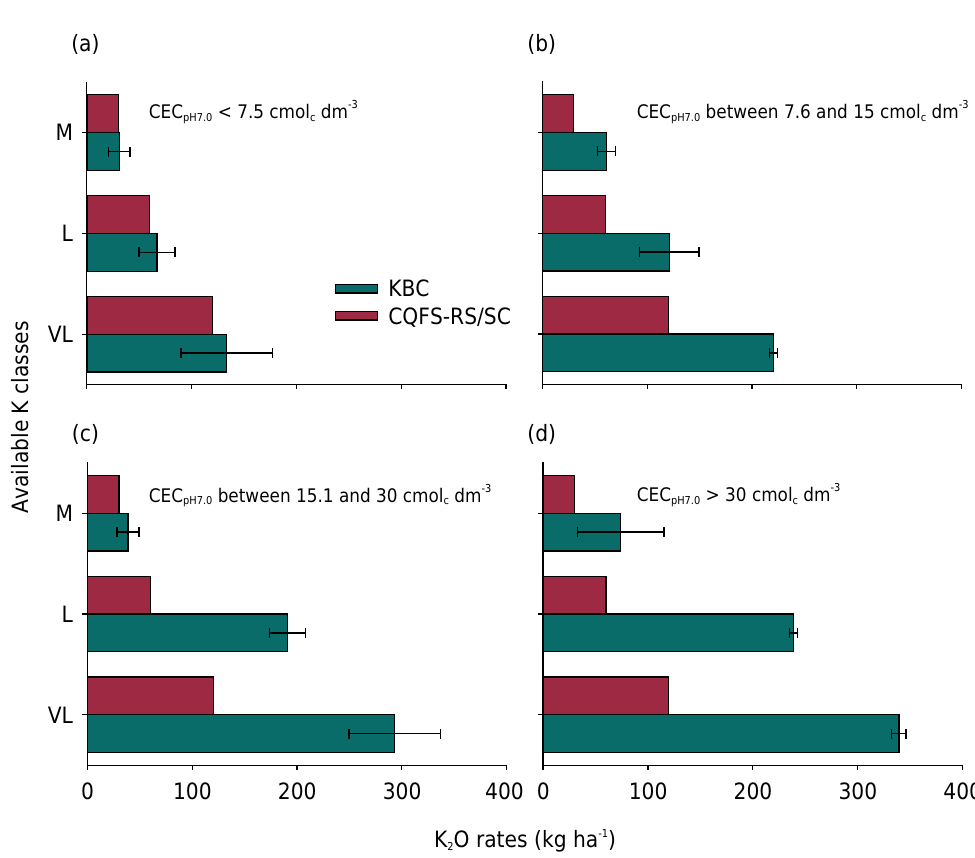
Figure 5. Comparison between the potassium (K) corrective fertilization recommendations between the Local Soil Fertility Committee and using the K buffering capacity (KBC), considering soils with different CEC pH7.0 . VL: Very Low; L: Low; M: Medium. Soils classified as “very low” had soil test K <20 mg dm -3 (a), <30 mg dm -3 (b), <40 mg dm -3 (c) and <45 mg dm -3 (d). Soils classified as “low” had soil test K between 21 and 40 mg dm -3 (a), between 31 and 60 mg dm -3 (b), between 41 and 80 mg dm -3 (c) and between 46 and 90 mg dm -3 (d). Finally, soils classified as “medium” had soil test K between 41 and 60 mg dm -3 (a), between 61 and 90 mg dm -3 (b), between 81 and 120 mg dm -3 (c) and between 91 and 135 mg dm -3 (d). The horizontal lines at the top of the bars represent the confidence interval